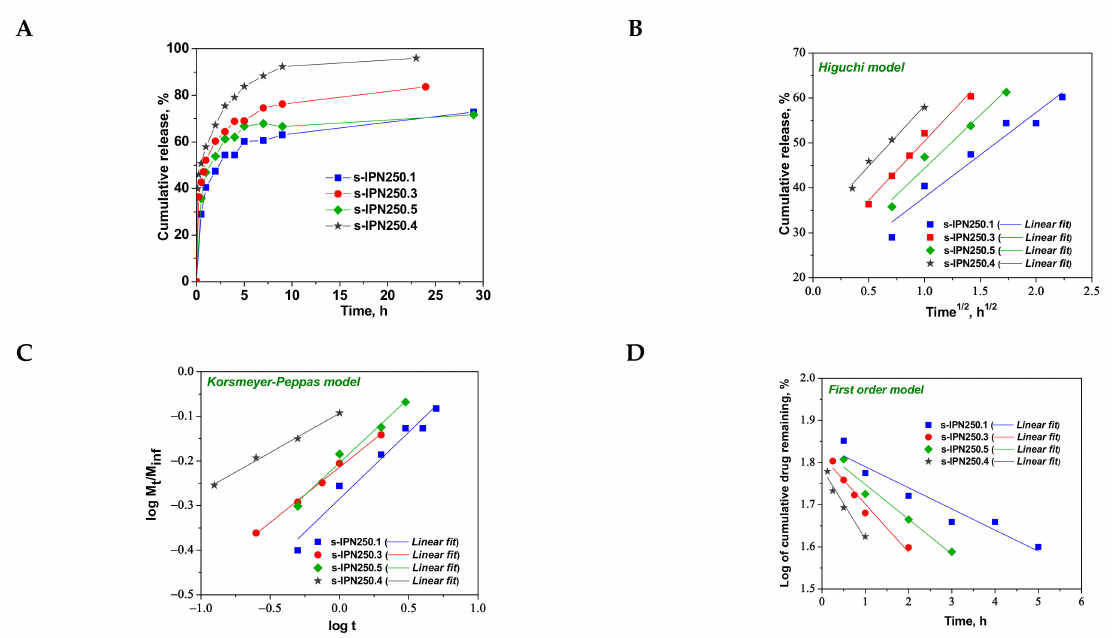
Figure 8. Cumulative release of CCM at pH 3.0, and 37 ◦ C, from semi-IPN with PDMAEMA250 entrapped in PAAm ( A ); fitting of kinetic models: Higuchi ( B ), Korsmeyer–Peppas ( C ), and first order ( D ) models.